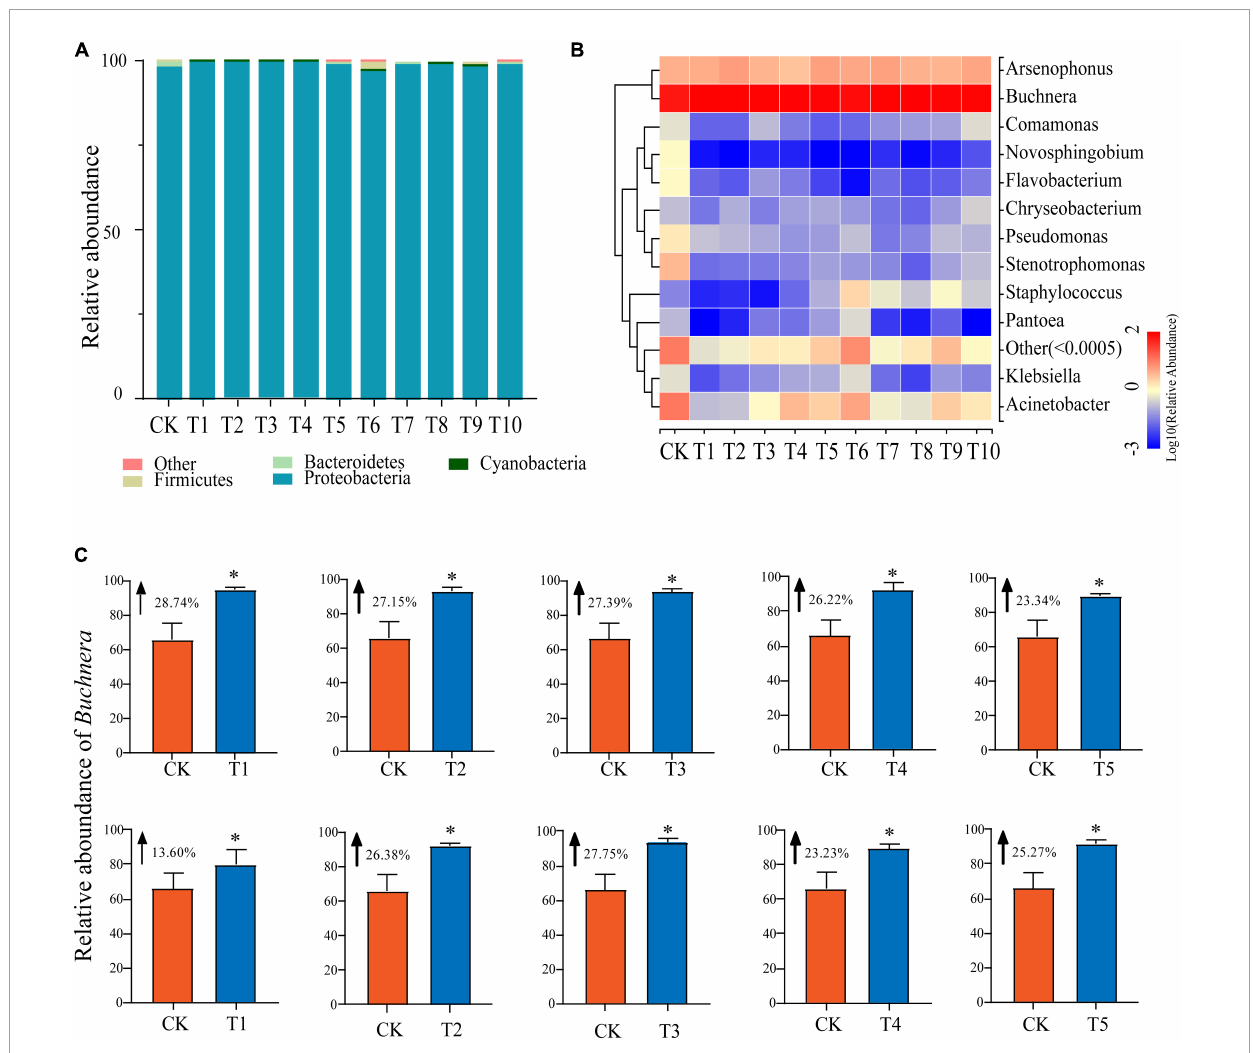
FIGURE2 Changes in relative abundance of symbiotic bacteria in cotton-specialized aphids fed on zucchini for 1 to 10 generations and the control group (CK). (A) Relative abundance of symbiotic bacteria in cotton-specialized aphids fed on zucchini for 1 to 10 generations and the control group (CK) at the phylum level. (B) Relative abundance of symbiotic bacteria in cotton-specialized aphids fed on zucchini for 1 to 10 generations and the control group (CK) at the genus level. (C) Transfer to the Zucchini host significantly affected the relative abundance of Buchnera in the microbial communities of cotton-specialized aphids. Pairwise comparison between the treatment group and CK, the data is mean ± SD. ∗ P <